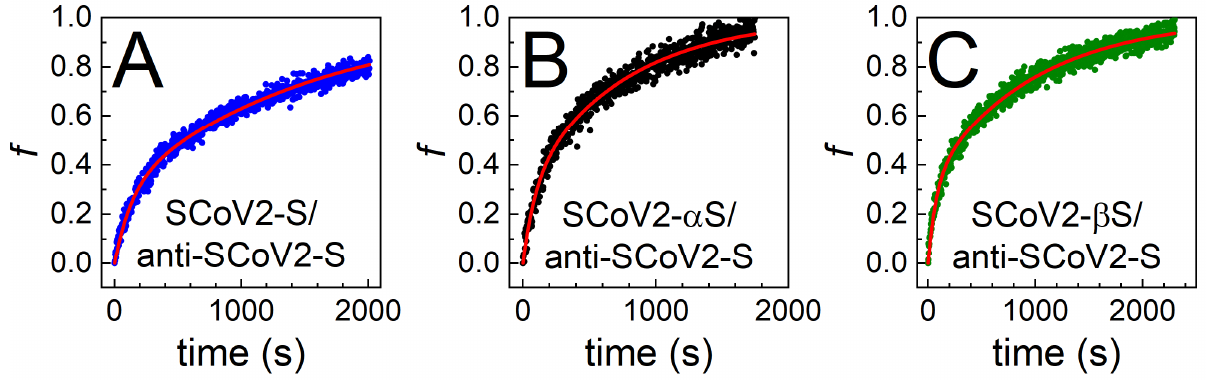
Figure 5. Normalized pAb-SCoV2-S antibody surface concentration ( f ) evolution in time obtained using 1:40 diluted blood serum during the formation of the immune complex with ( A ) SCoV2-S, ( B ) SCoV2-αS, ( C ) SCoV2-βS. Points correspond to experimentally obtained results, while lines for fitting are derived by using two-step irreversible binding immune complex formation mathematical modeling.